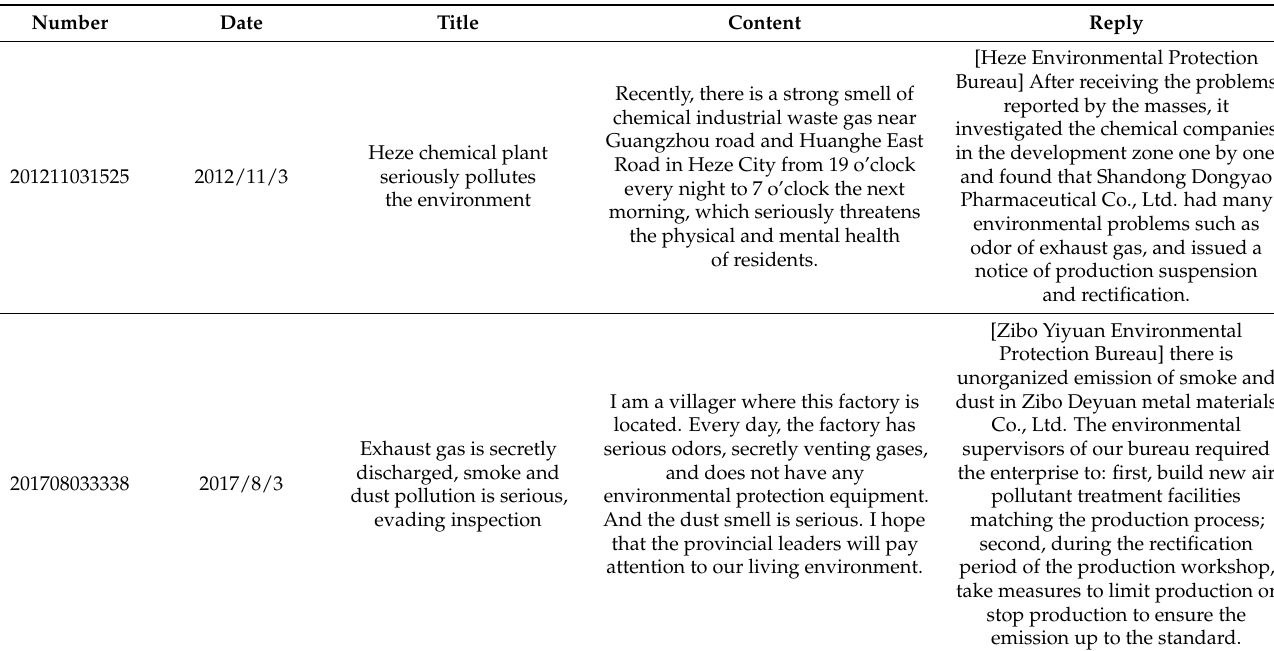
Table 1. Sample data of public